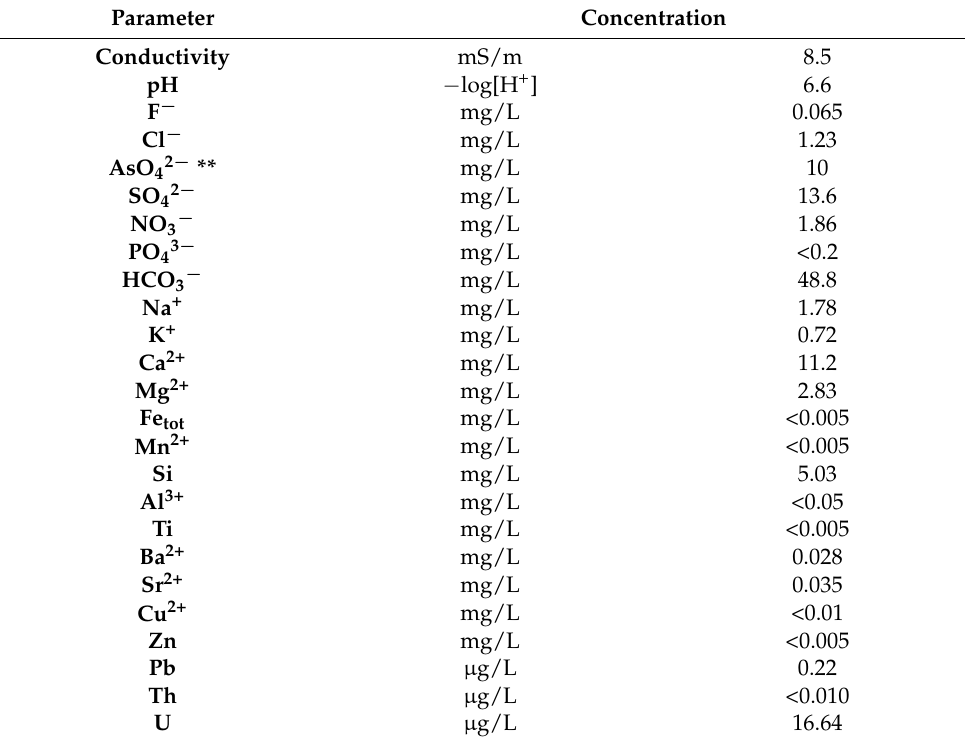
Table 11. Physicochemical parameters of water used for thermodynamic modeling